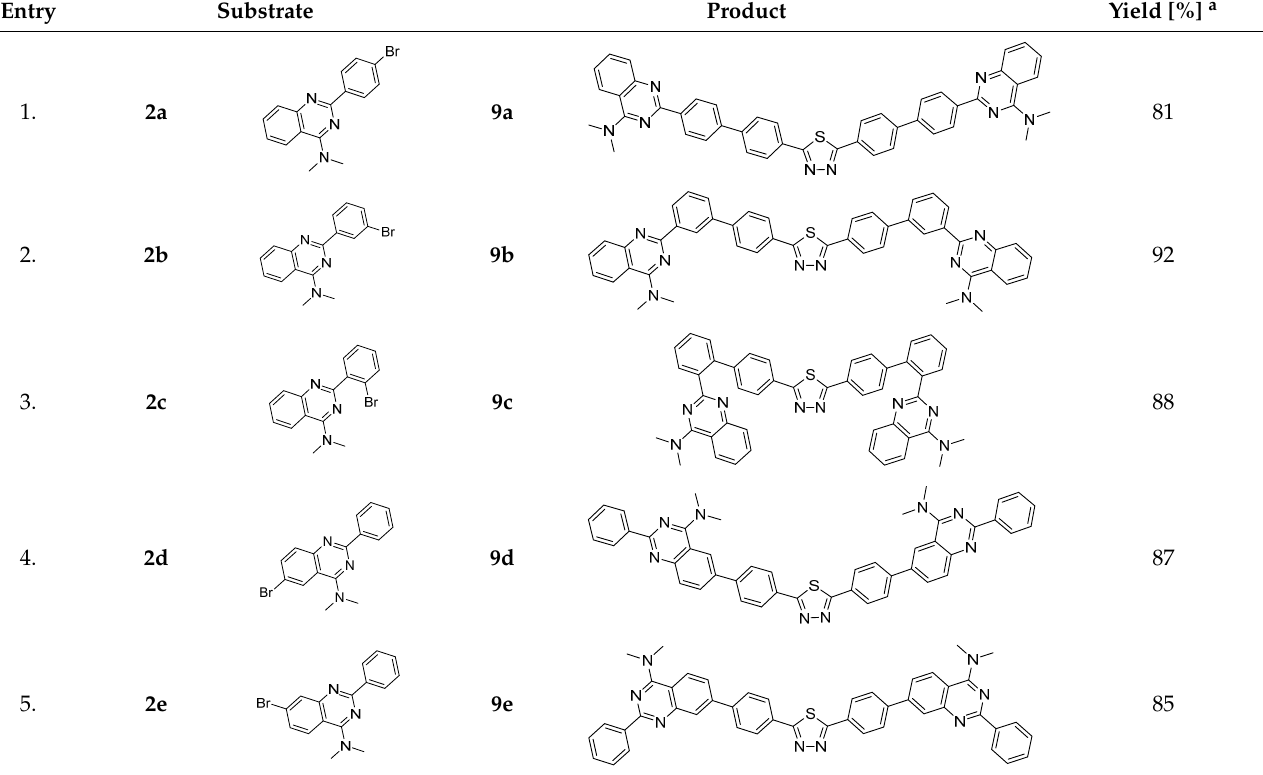
Table 3. Symmetrical quinazolinylphenyl-1,3,4-thiadiazole derivatives ( 9a – e ) synthesized via Suzuki cross-coupling reactions.